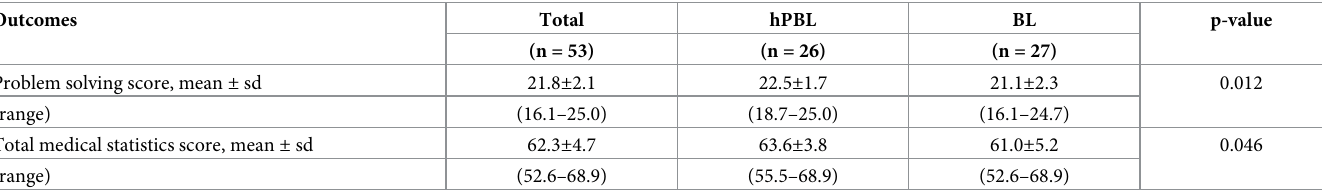
Table 3. Outcomes among two groups of